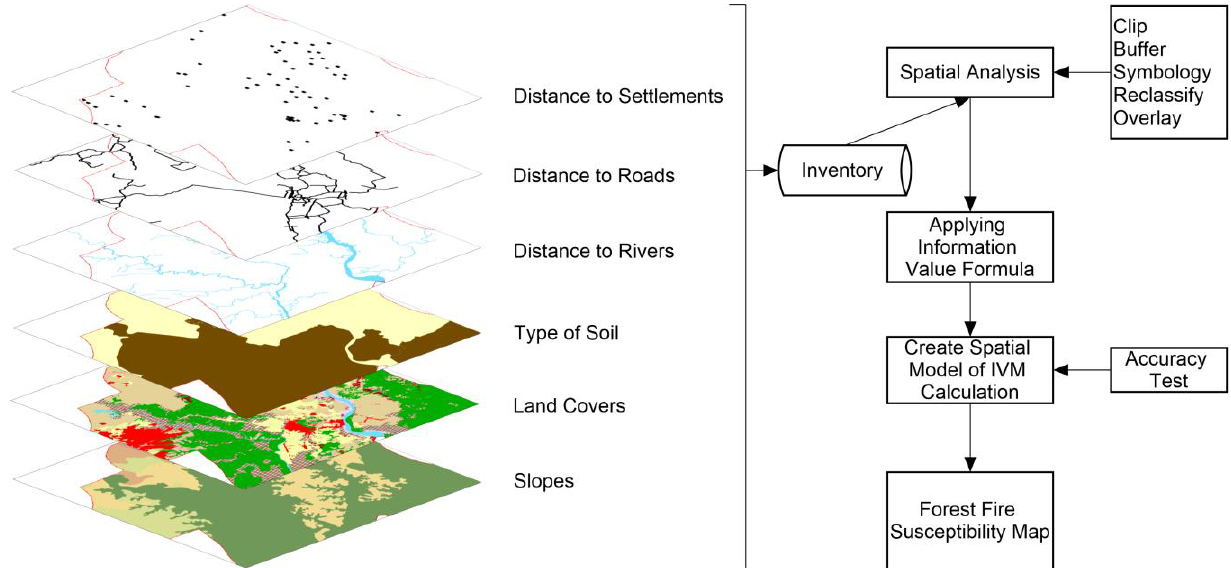
Figure 2. Flowchart of research methodology.